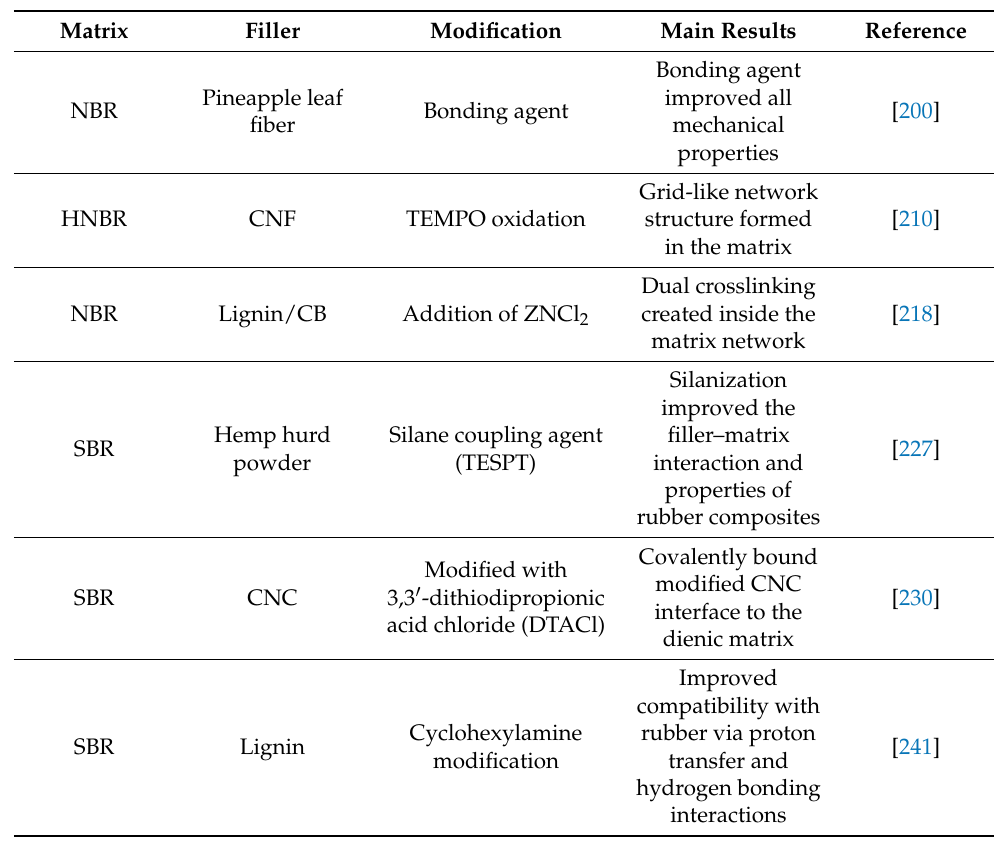
Table 8. Examples of NBR and SBR biocomposites reinforced with lignocellulosic fillers.